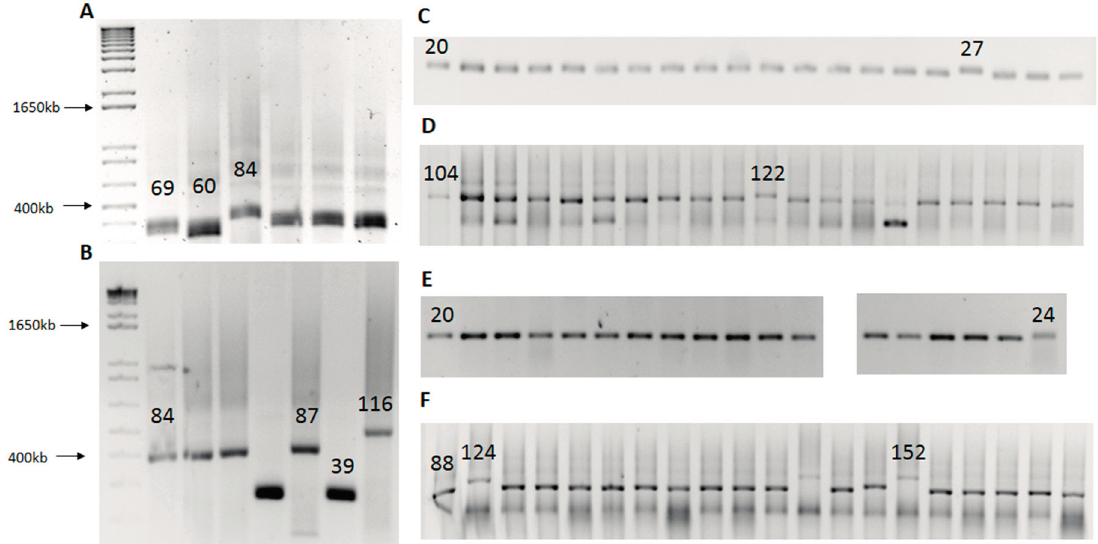
Figure 3. Screen of ATXN3 constructs generated by using the SLIP method. SLIP of ATXN3 with, ( A ) 69 CAG repeats; ( B ) 84 CAG repeats; ( C ) 20 CAA repeats; ( D ) 104 CAA repeats; ( E ) 20 CAA-interrupted CAG (1:3 ratio) repeats; and ( F ) 88